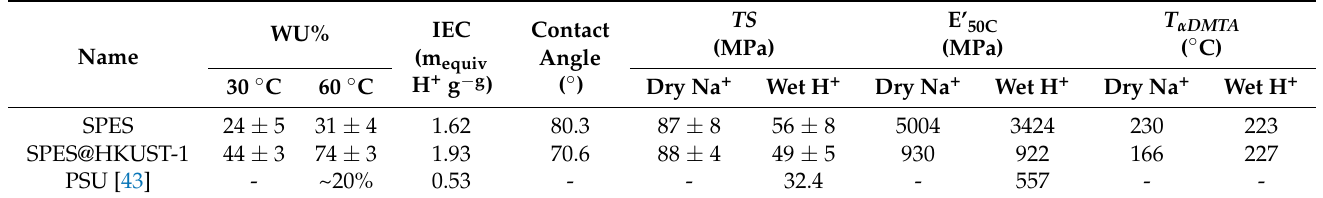
Table 1. Characteristic parameters of the pristine SPES and hybrid SPES@HKUST-1